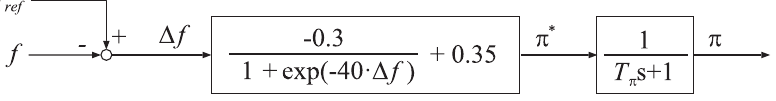
Figure 9. Configuration of